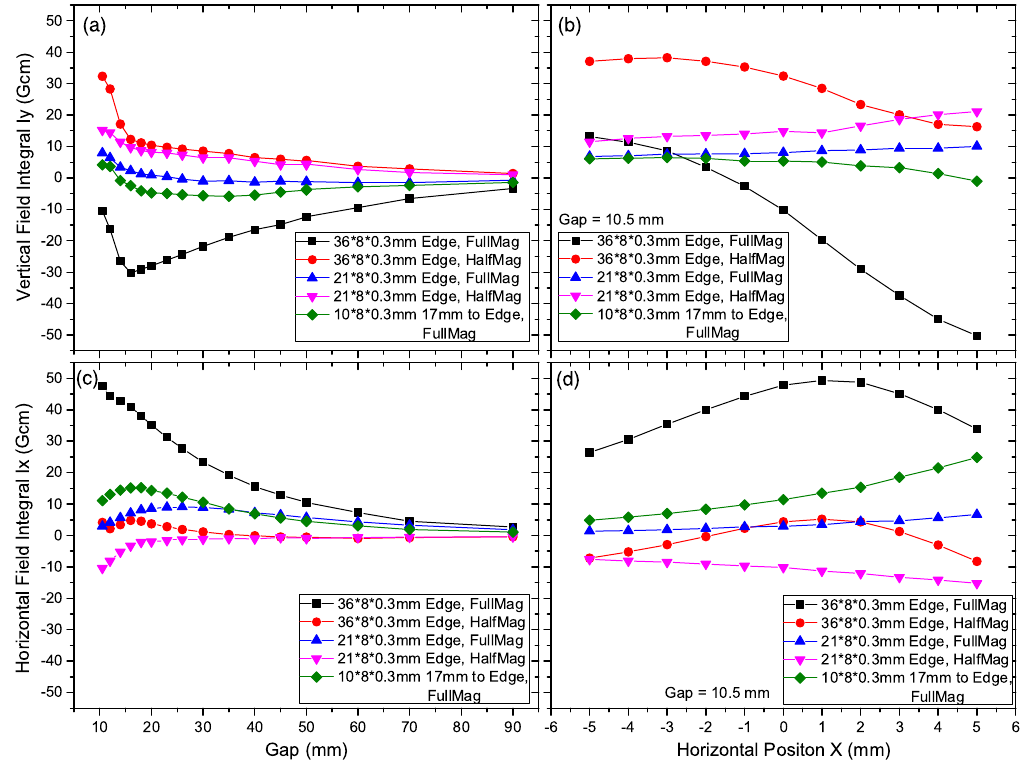
FIG. 7. (a) Gap signatures for the vertical field of the five types of shims selected for tuning. (b) Vertical field integral vs x . (c),(d) The corresponding signatures to (a) and (b) for the horizontal field integral. The gap signatures for the gradient were evaluated from the slope at x ¼ 0 . Shim dimensions and positions with respect to magnet edges are